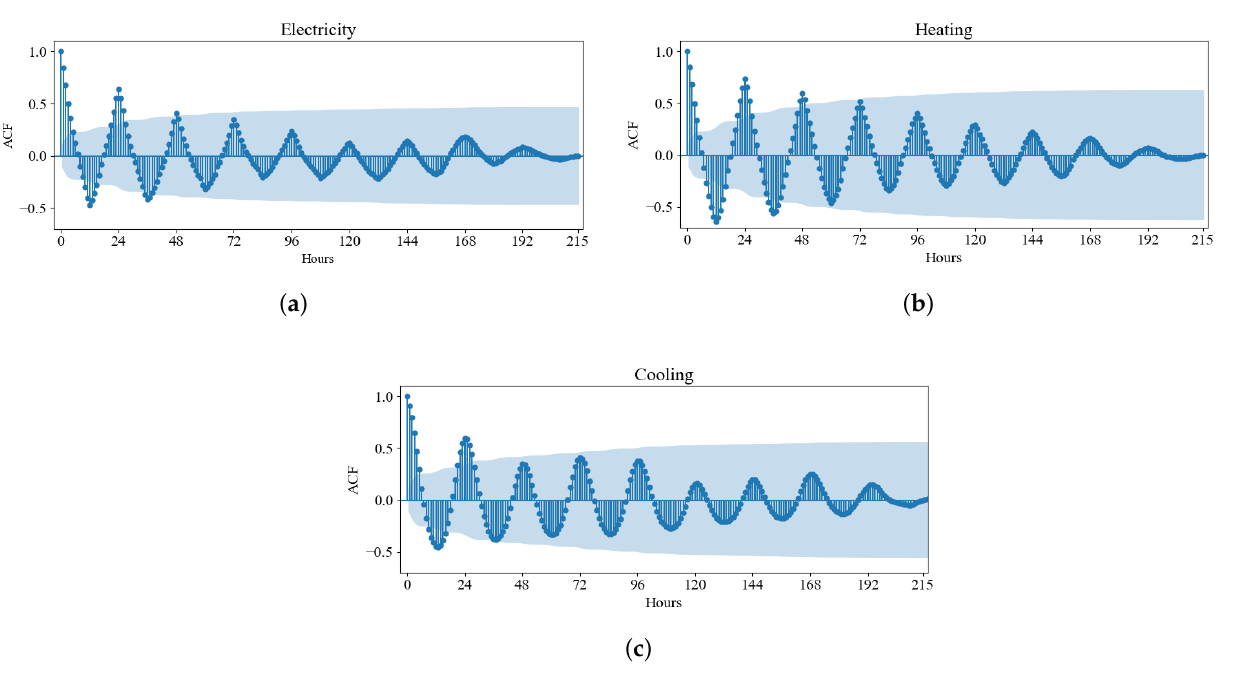
Figure 2. The loads temporal auto-correlation. ( a ) The electricity load temporal auto-correlation. ( b ) The heating load temporal auto-correlation. ( c ) The cooling load temporal auto-correlation. In the IES system, there is a mutual transformation and complementary characteristic between the individual energies, and this unclear coupling relationship affects the accurate accuracy of the power system to an extent. The correlation between the factors is analyzed by the Person correlation coefficient method, and the analysis results are plotted by heat map as shown in Figure 3.